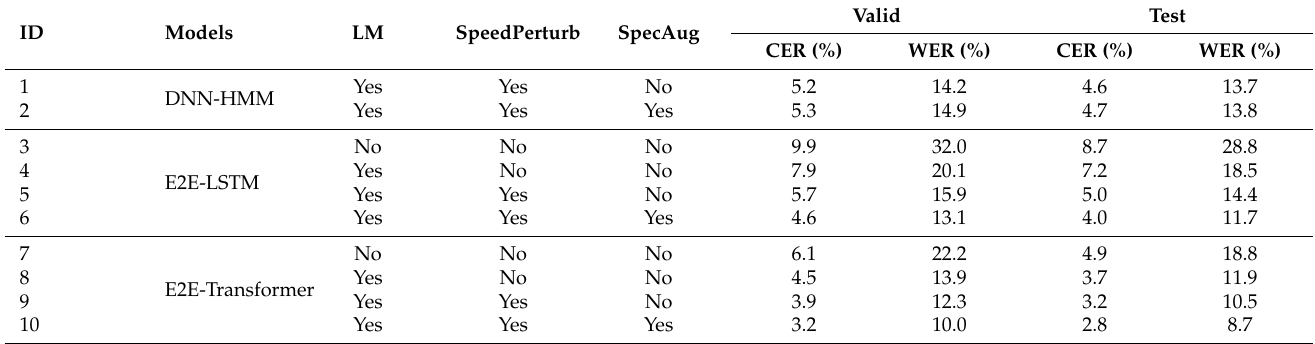
Table 5. SOTA results tested on KSC [114]. LM represents the language model; SpeedPerturb and SpecAug represent speed perturbation and SpecAugment,